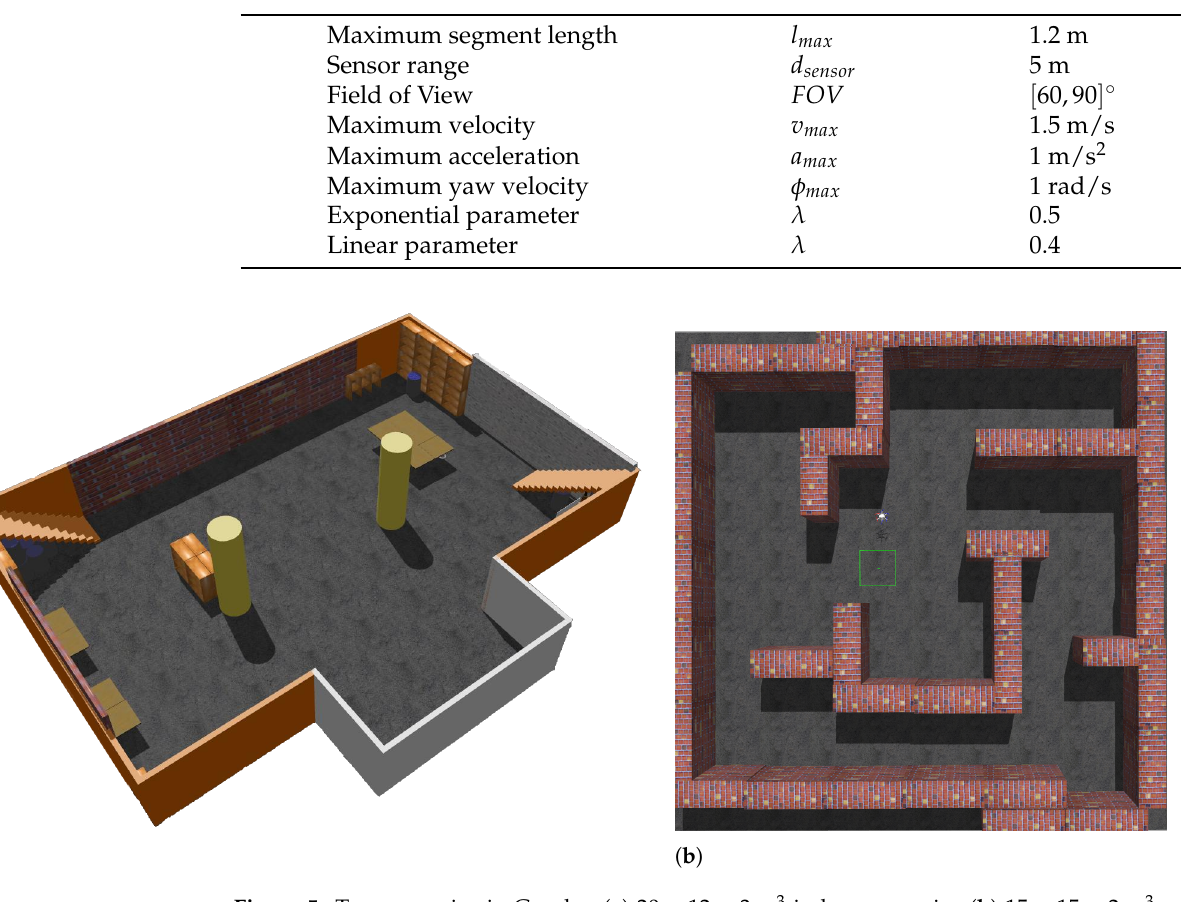
Table 1. Parameters of the proposed planner.